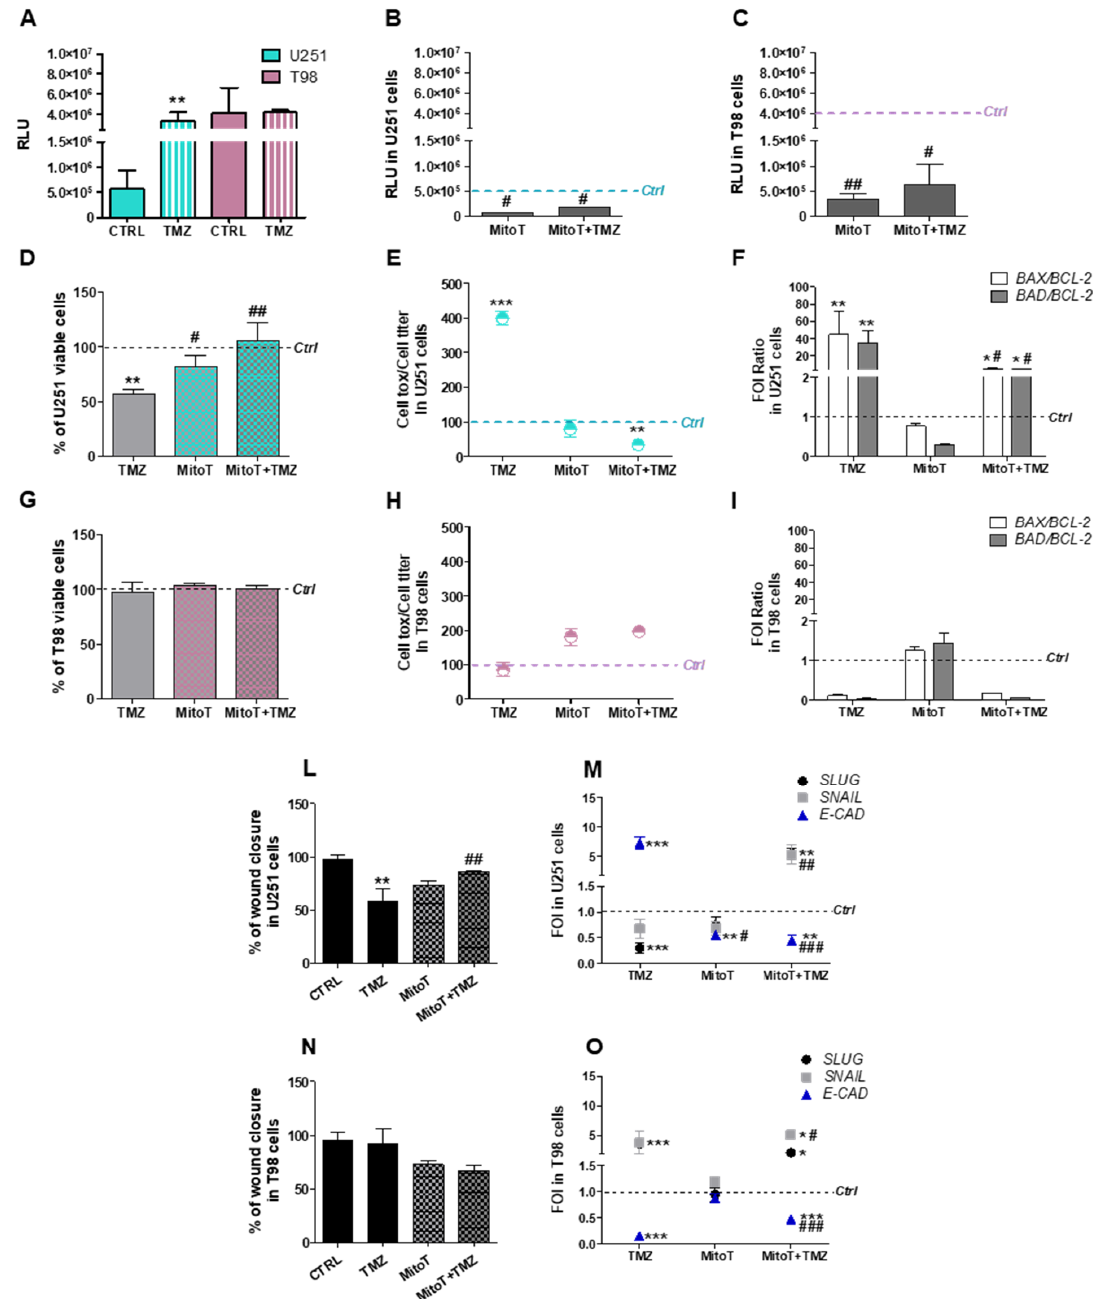
Figure 1. Crucial role of mitochondrial reactive oxygen species (ROS) in Temozolomide-responsiveness in U251 and T98 cells. ( A ) Luminescent assay applied to measure H 2 O 2 levels in cell culture medium of U251 and T98 cells in untreated cells and after 24 h treatment with 100 µ M Temozolomide (TMZ). Data were expressed as relative luminescence units (RLU) obtained by luciferase counts normalized for the amount of proteins quantified by Bradford assay. ** p < 0.01 vs. control cells. ( B ) ROS levels measured in U251 and ( C ) T98 cells after 1h of treatment with MitoTempo (MitoT) 25 µ M ± TMZ for 24 h. Data were expressed as RLU. # p < 0.05, ## p < 0.01 vs. TMZ-treated cells. ( D ) Viability of U251 and ( G ) T98 cells, assessed by means of Trypan blue exclusion test, and expressed as the percentage of viable cells after treatment with 100 µ M TMZ ± 25 µ M MitoT. ** p < 0.01 vs. control cells; # p < 0.05, ## p < 0.01 vs. TMZ-treated cells. ( E ) Cell toxicity in U251 and ( H ) T98 cells analyzed by Cell Tox Green normalized on Cell Titer Glo and expressed as percentage compared to control cells. *** p < 0.001 vs. control